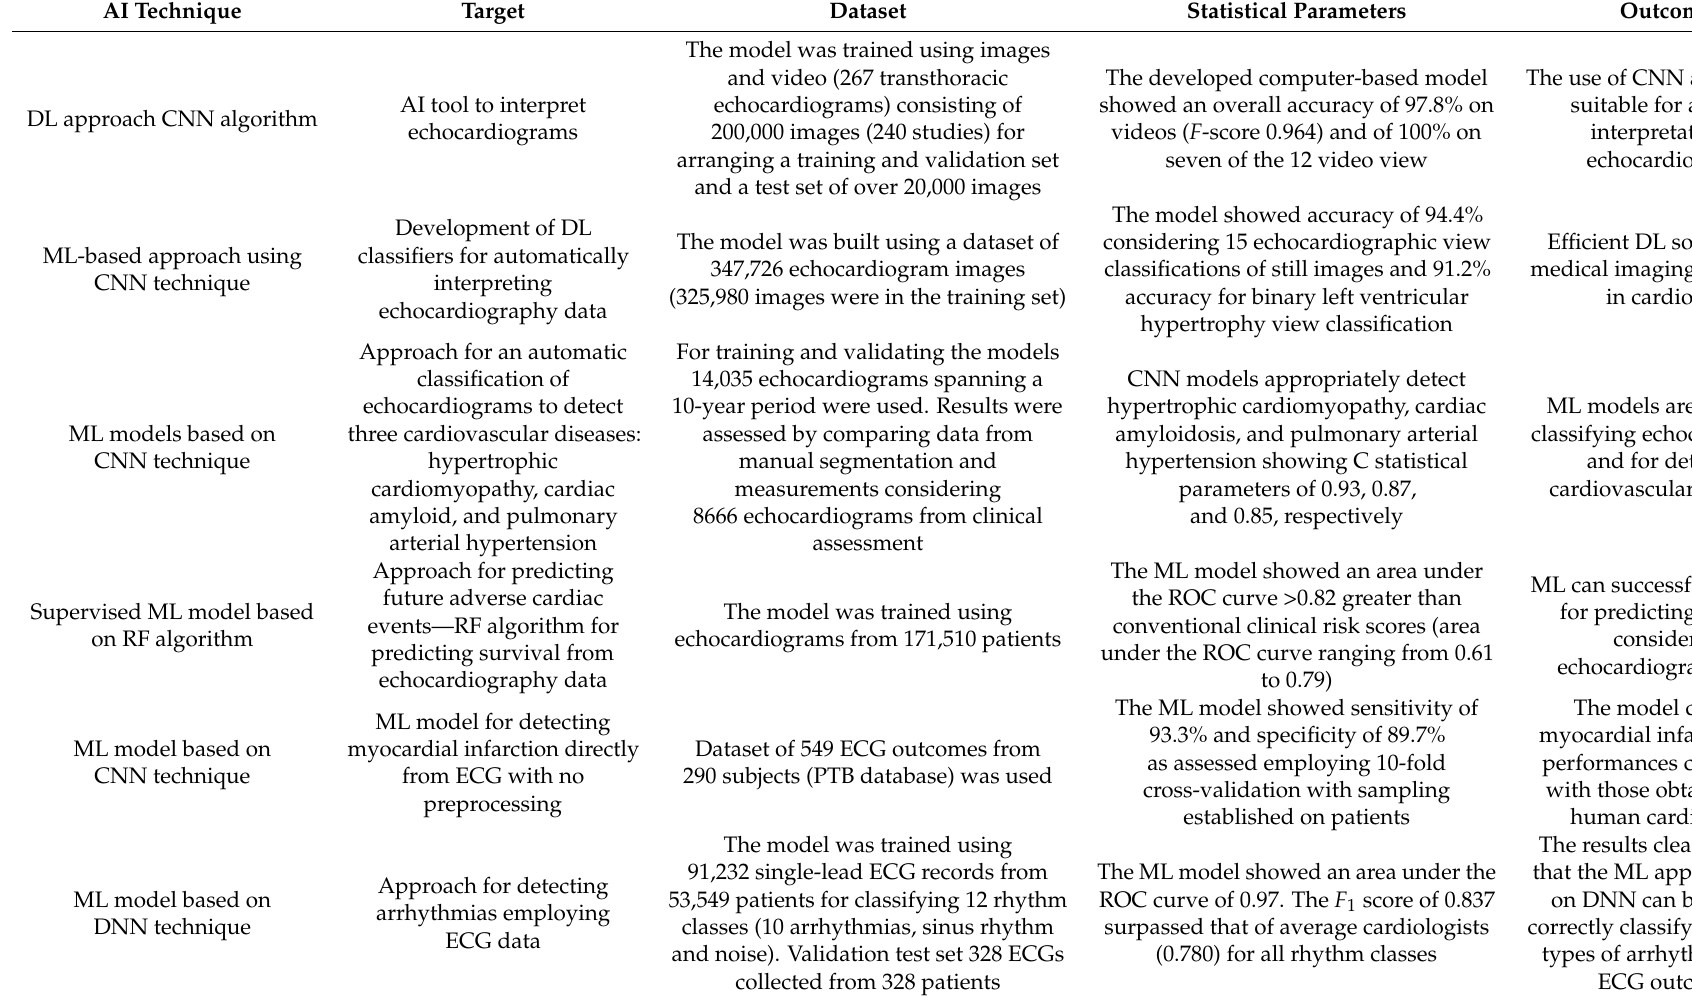
Table 7. Main examples of AI/ML in cardiology and cardiovascular